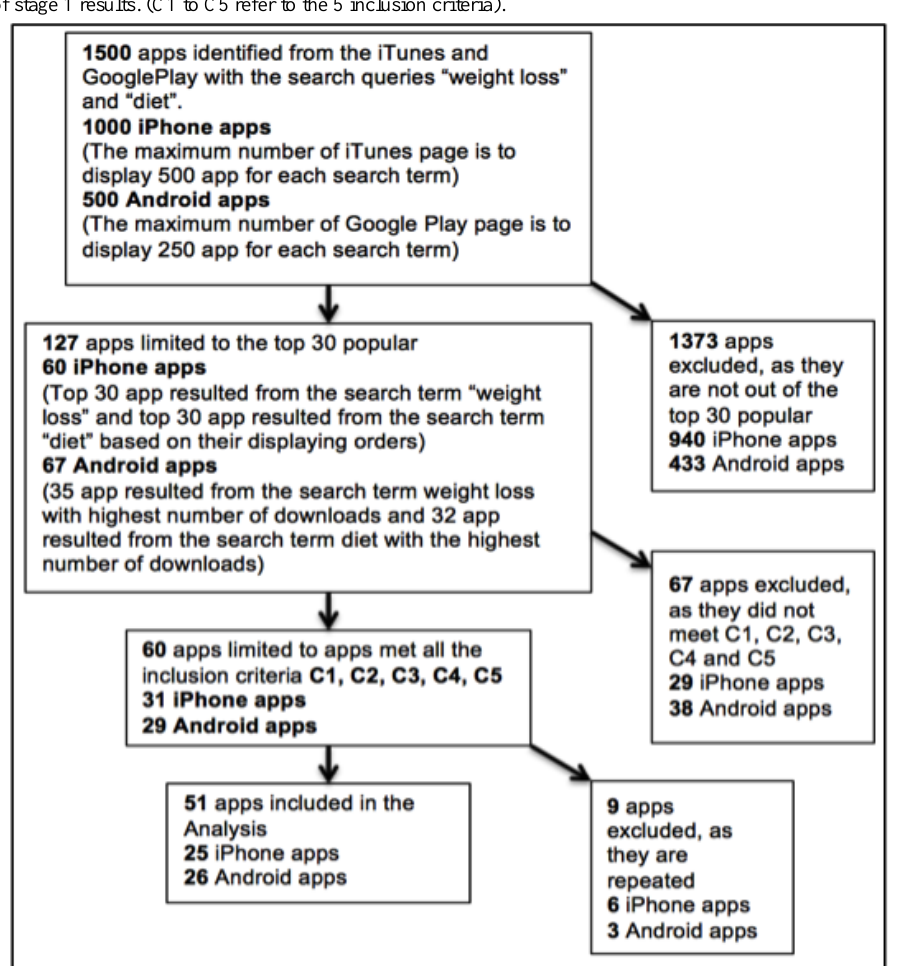
Figure 1. Summary of stage 1 results. (C1 to C5 refer to the 5 inclusion